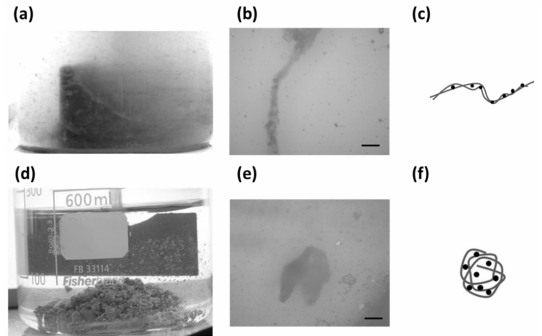
Figure 15. Images of the jars taken after 10 min of stirring at 25 s − 1 for ( a ) anionic polyelectrolyte and ( d ) cationic polyelectrolyte based suspensions. Micrographs of ( b ) anionic floc and ( e ) cationic floc. Scale bar represents 70 µ m. Pictorial representation of ( c ) anionic floc and ( f ) cationic floc based on the micrographs. All experiments are done in